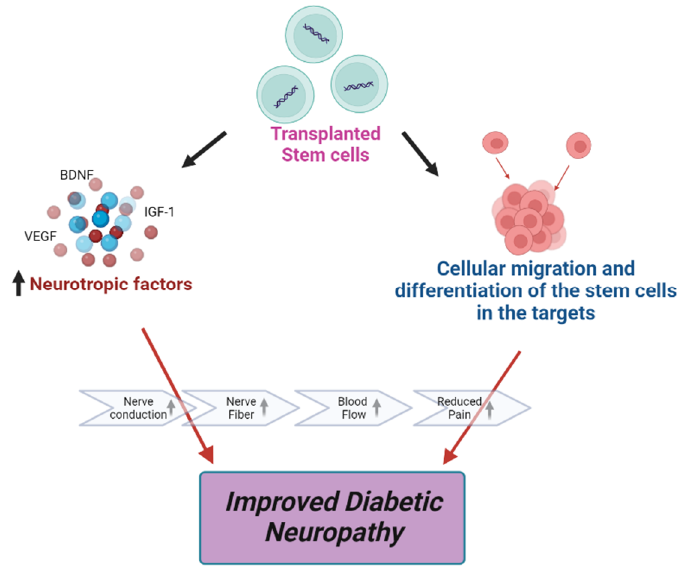
Figure 2. Effects of stem cell therapy on DPN.